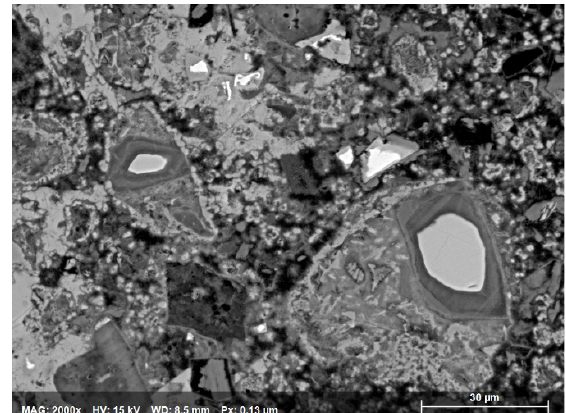
Figure 6. SEM-BSE image of the micro-structure of the composite cement containing cRCP. The grains occupied initially by the alumina- silica gel are filled with the hydrates, mainly C-(A)-S-H phase. Furthermore, the slag grains originating from the cRCP show hydration rims, indicating a post hydration of this phase in the composite cement Simplified CO 2 and energy